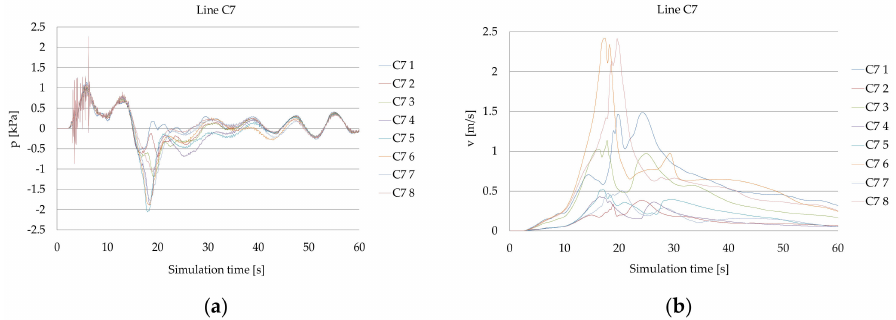
Figure 9. Results of the CFD simulation for Ferry2—both the bow thrusters operating with 105 kN thrust each during the period of time of 10 s: ( a ) pressure in the C7 line; ( b ) velocity on the quay wall in the C7